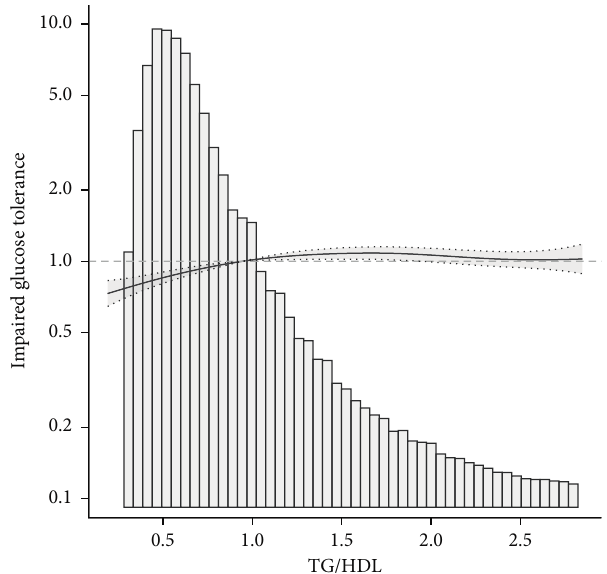
Figure 2: Association between TG/HDL and impaired glucose tolerance.